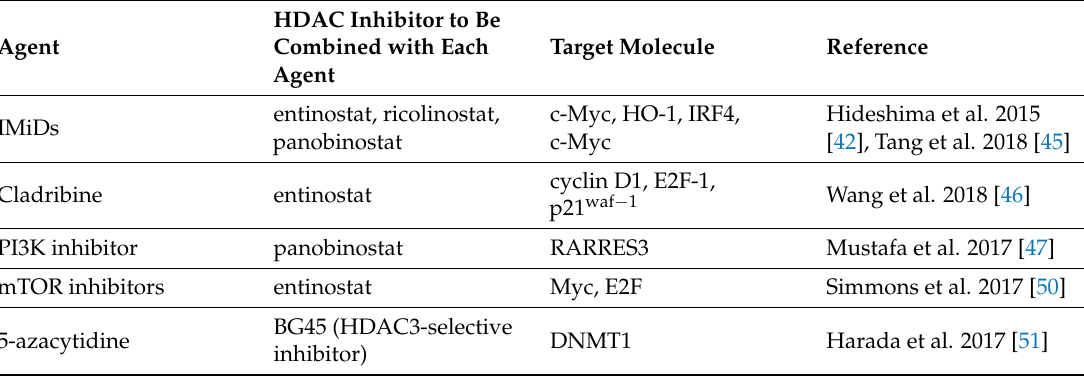
Table 2. Summary for combinatory approaches using HDAC